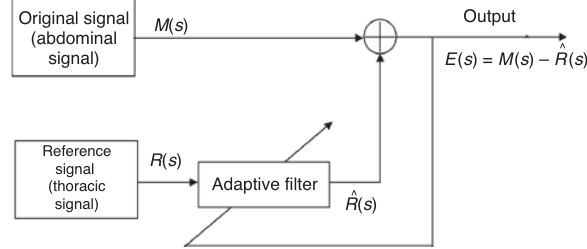
Figure 1: Adaptive Noise Cancellation Method.